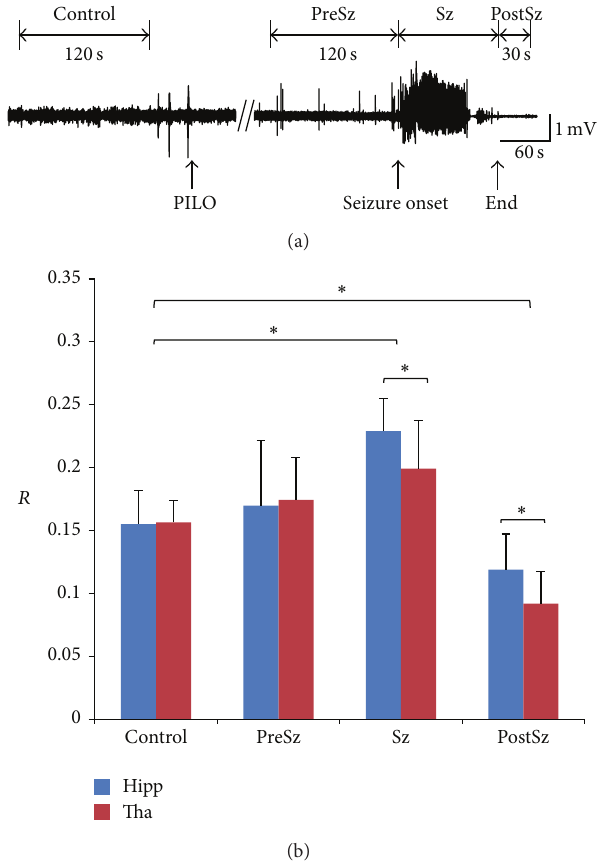
Figure 4: Statistics analysis result of signal redundancy for all 9 mice. (a) Time periods’ definition. Control period contains 120s before the pilocarpine injection. Pre-seizure (PreSz) time period is before the seizure onset with 120-s long. Post-seizure (PostSz) time period is immediately after seizure termination with 30 s long. Time period between seizure onset and termination is denoted as “Sz.” (b) Statistical analysis results of redundancy ( 𝑅 ). Error bar means standard deviation. Stars ( ∗ ) indicate statistically significant differences between the distributions for control period and the following three time periods (pair-wised 𝑡 -tests, significance level 𝑃 < 0.05 ). Hipp, hippocampus; Tha, thalamus; PILO,